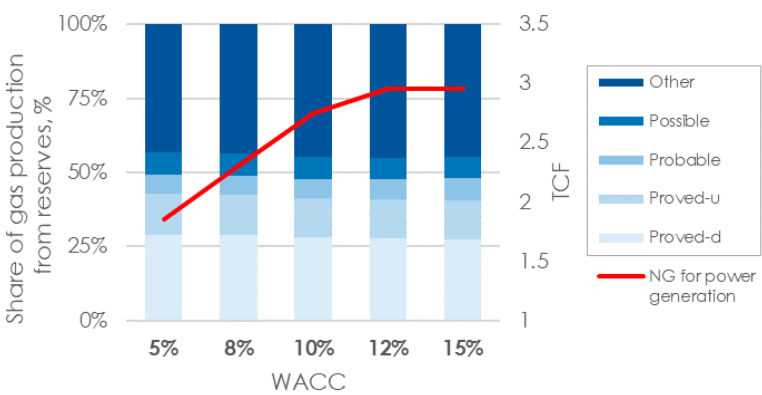
Figure 7. Accumulated natural gas production from reserves 2013–2040.